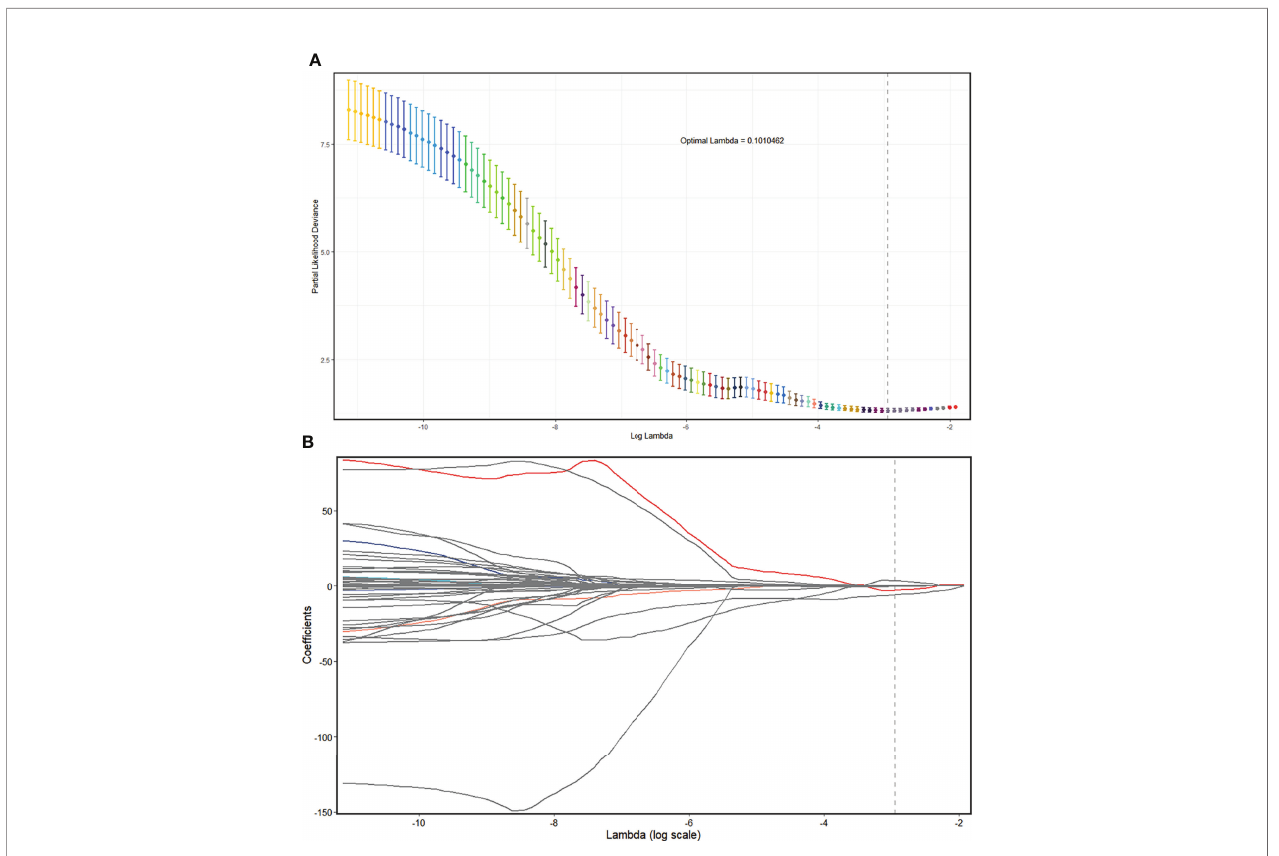
FIGURE 5 | Radiomics feature selection using the LASSO regression model in the CECT model. (A) The partial likelihood deviance from the LASSO regression cross-validation procedure was plotted against log( l ). The optimal l value of 0.1010462 was selected. (B) LASSO coef fi cient pro fi les of the radiomics features. As the tuning parameter ( l ) increased using 10-fold cross-validation, more coef fi cients tended to approach 0 and the optimal non-zero coef fi cients were generated, which yielded a set of the optimal radiomics features. LASSO, least absolute shrinkage and selection operator; CECT, contrast-enhanced computed